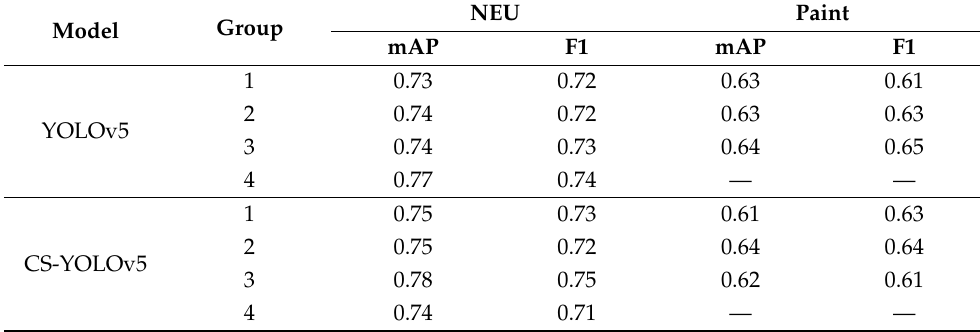
Table 3. mAP and F1-score with different positive classes.